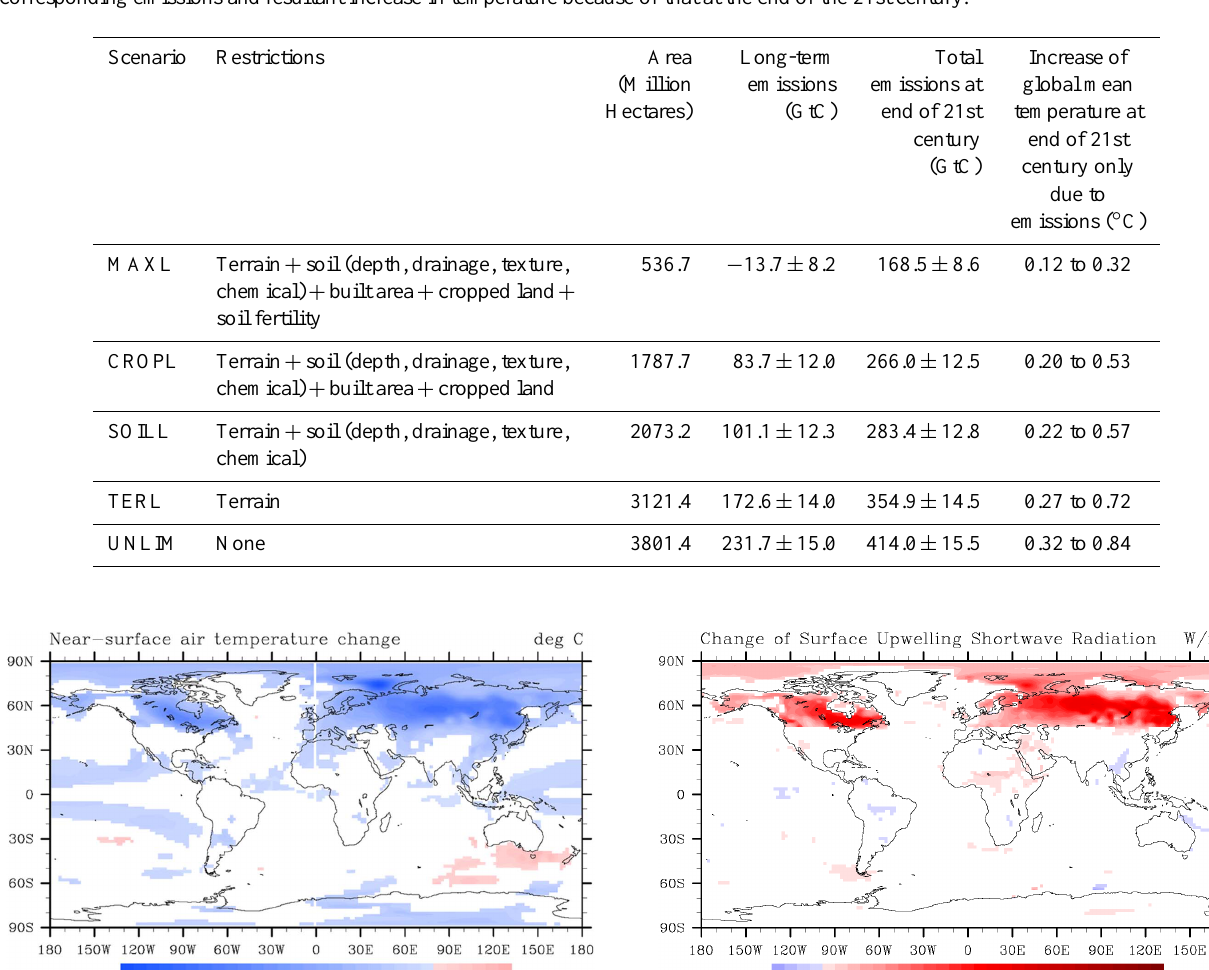
Table 4. Different land management scenarios (their restrictions included), the corresponding area available for bioenergy plantations, the corresponding emissions and resultant increase in temperature because of that at the end of the 21st century.